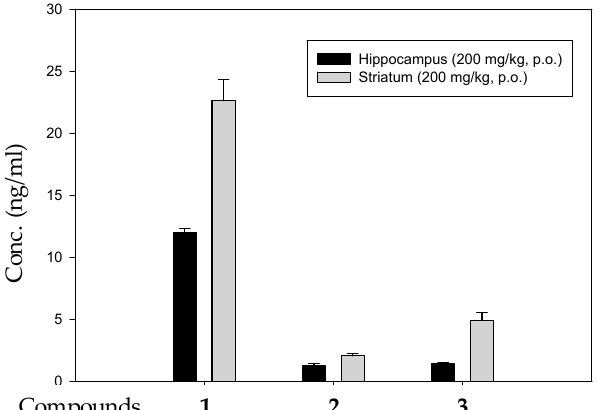
Figure 4. The phenylethanoid glycosides ( 1 – 3 ) were detectable in rat brain tissues [19] using UPLC/MS/MS. The data represented mean ± S.D., n = 3 for each group.